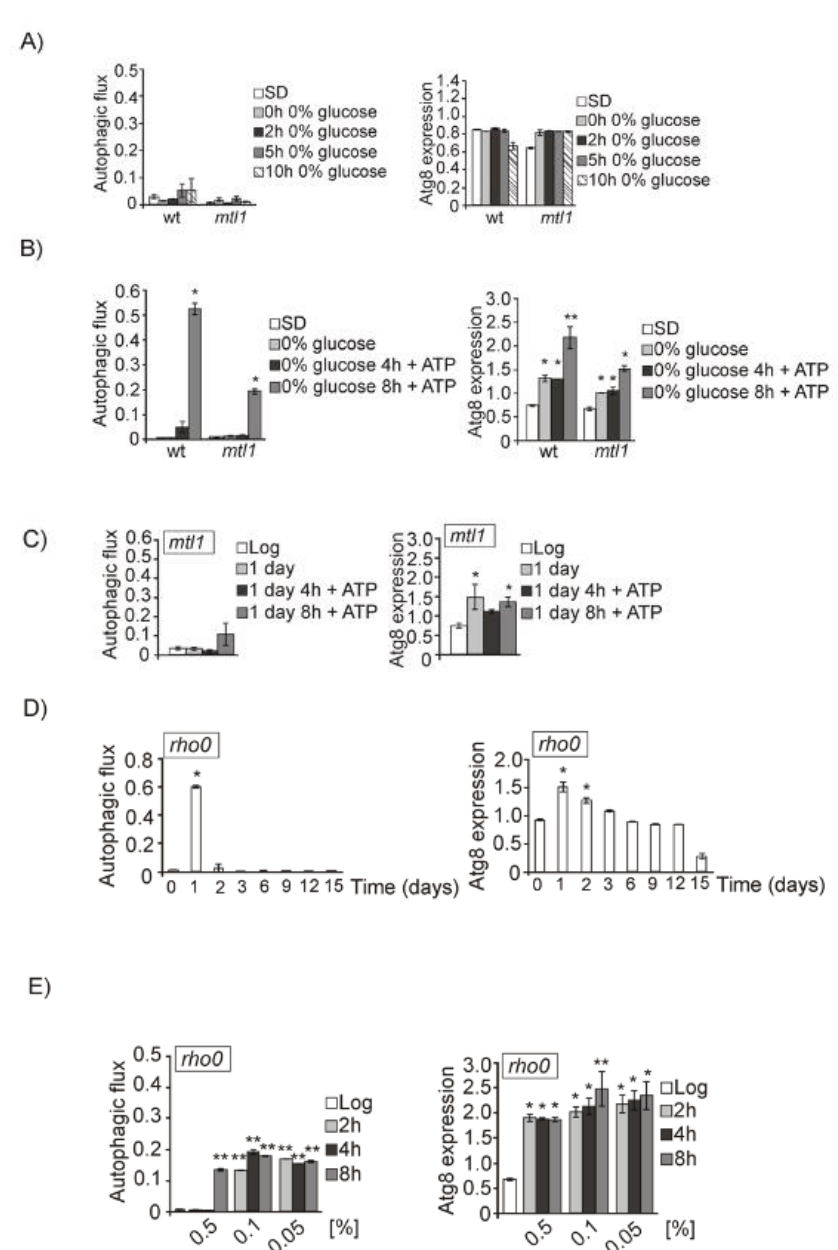
Figure 5. Mtl1 signals a decrease in glucose concentration to the autophagy machinery in a manner not fully dependent on ATP production by mitochondria. ( A ) wt and mtl1 cells expressing GFP–Atg8 grown in SD media were transferred to minimum media devoid of glucose (0% glucose) to determine autophagic flux and Atg8 expression as in Figure 1B. ( B ) Upon transference to minimum media without glucose, ATP (at 200 mM final concentration) was added to the cultures described in ( A ) and samples were collected at the indicated times for determination of autophagy as in ( A ). ( C ) ATP (200 mM) was added to mtl1 cultures growing in SD minimum medium for one day at the diauxic shift, and samples were collected at 4 and 8 h for autophagic flux and Atg8 expression determination, as in Figure 1B. ( D ) A rho0 mutant expressing GFP – Atg8 was grown (as in Figure 1B) for autophagy determination. ( E ) rho0 cells exponentially growing in SD were washed and transferred to several media containing different glucose concentrations to analyze autophagy, as in Figure 4A. Error bars in the histograms represent the standard deviation (SD) calculated from three independent experiments. Significance of the data was determinate by p -values from a Student’s unpaired t -test denoted as follows: * = 0.05 > p > 0.01; ** = 0.01 > p >